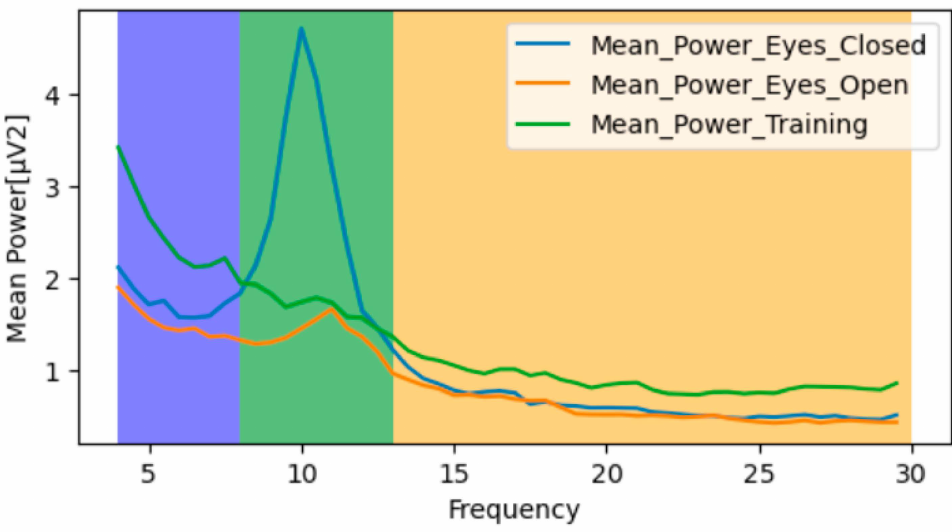
Figure 6. Illustration of mean power of participants in eyes closed, eyes open, and VSW training phases. Violet color represents theta, green color represents alpha, and yellow color represents beta frequency bands.